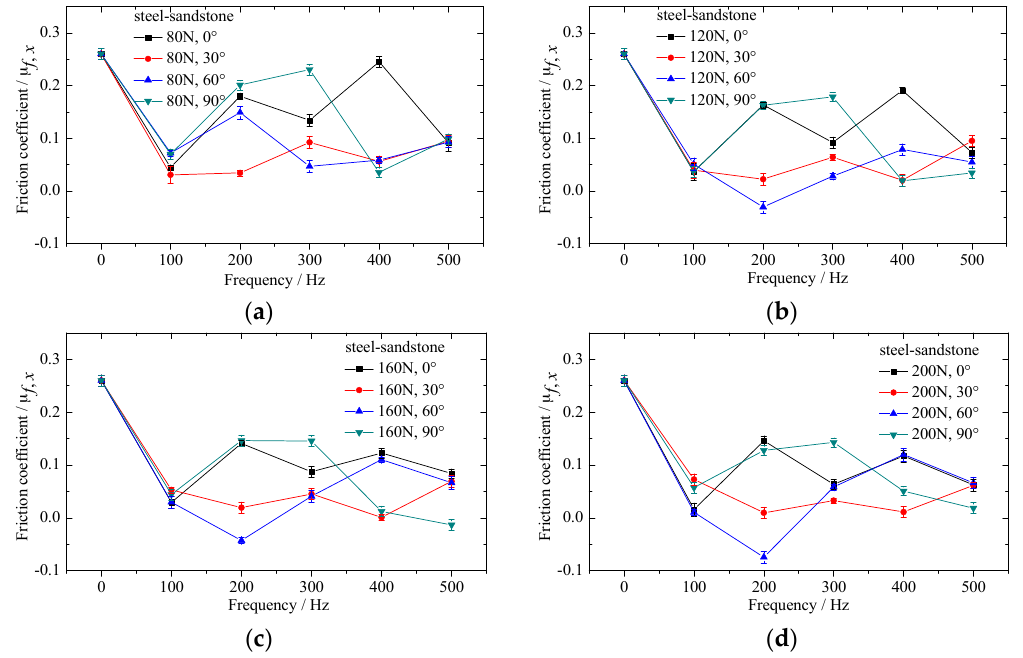
Figure 6. Effect of in-plane vibration on frictional coefficient between alloyed steel and sandstone. ( a ) Exciting force equals to 80N; ( b ) exciting force equals to 120N; ( c ) exciting force equals to 160N and ( d ) exciting force equals to 200N.